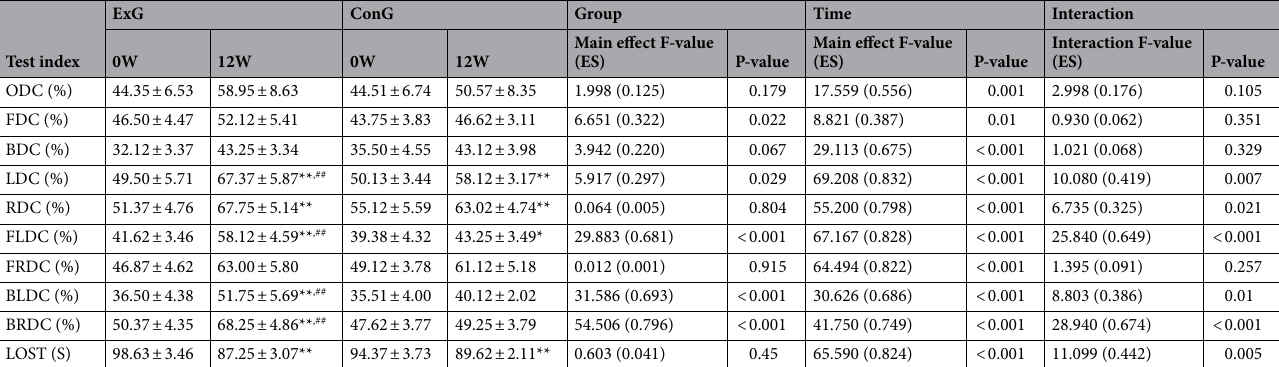
Table 4. Subjects’ limits of stability (LOS) 2 × 2 repeated measures ANOVA test. Within-group differences *P < 0.05, **P < 0.01; Differences between groups # P < 0.05, ## P < 0.01.